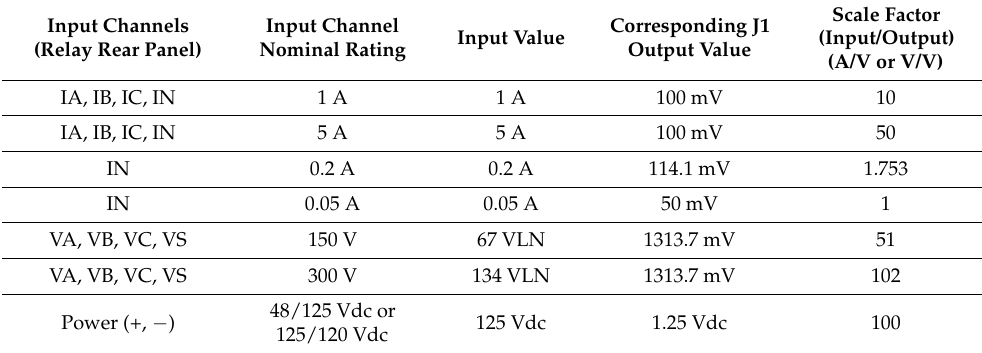
Table 2. Scaling factors for SEL-351